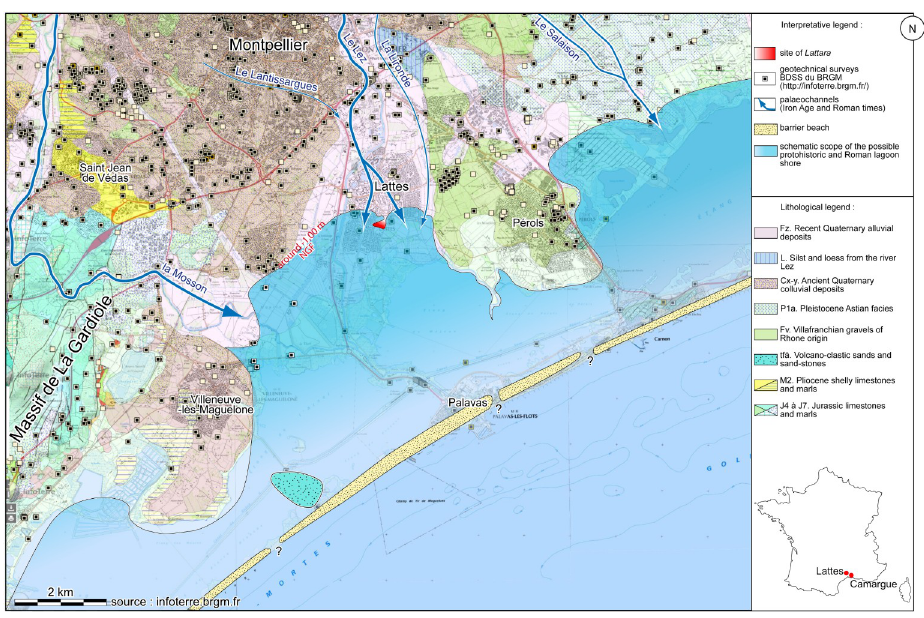
Fig 1. Geomorphological interpretation of the Lattara area and coastline during Iron Age and Roman times. The site of Lattara is marked in red.